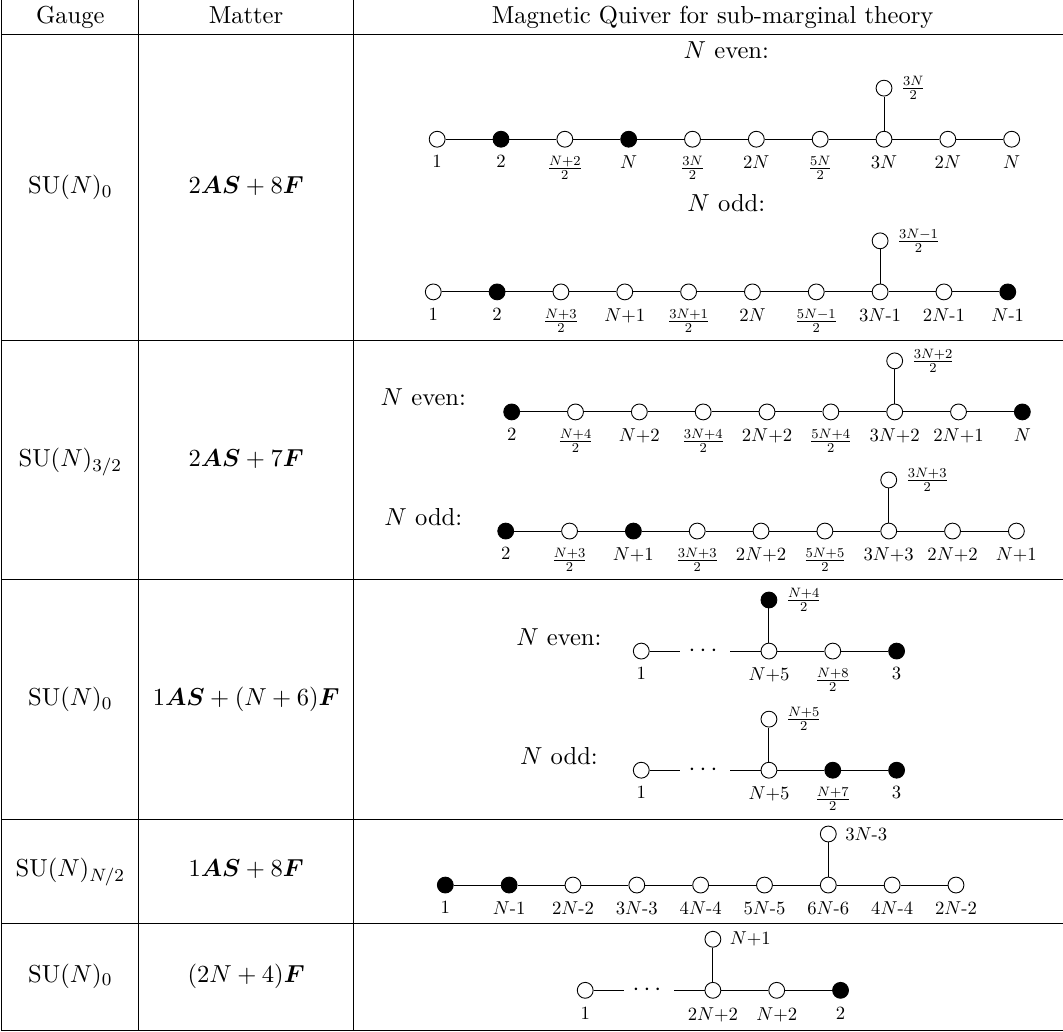
Table 1 . Marginal or KK-theories with single gauge group, which we will discuss. The magnetic quiver is shown for the theory obtained after decoupling one of the fundamental matter fields. These theories will be referred to as sub-marginal. The white nodes in the quivers are the balanced nodes which encode the flavor symmetry algebra, see